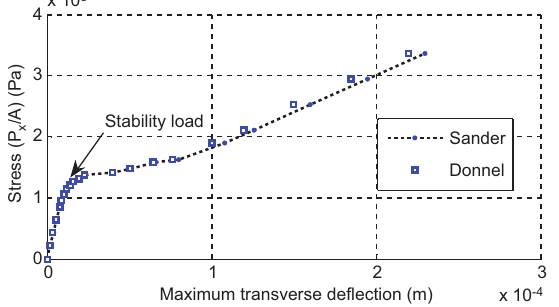
Figure 2 Load-defl ection curve for uniform-thickness curved plate with ply confi guration [0